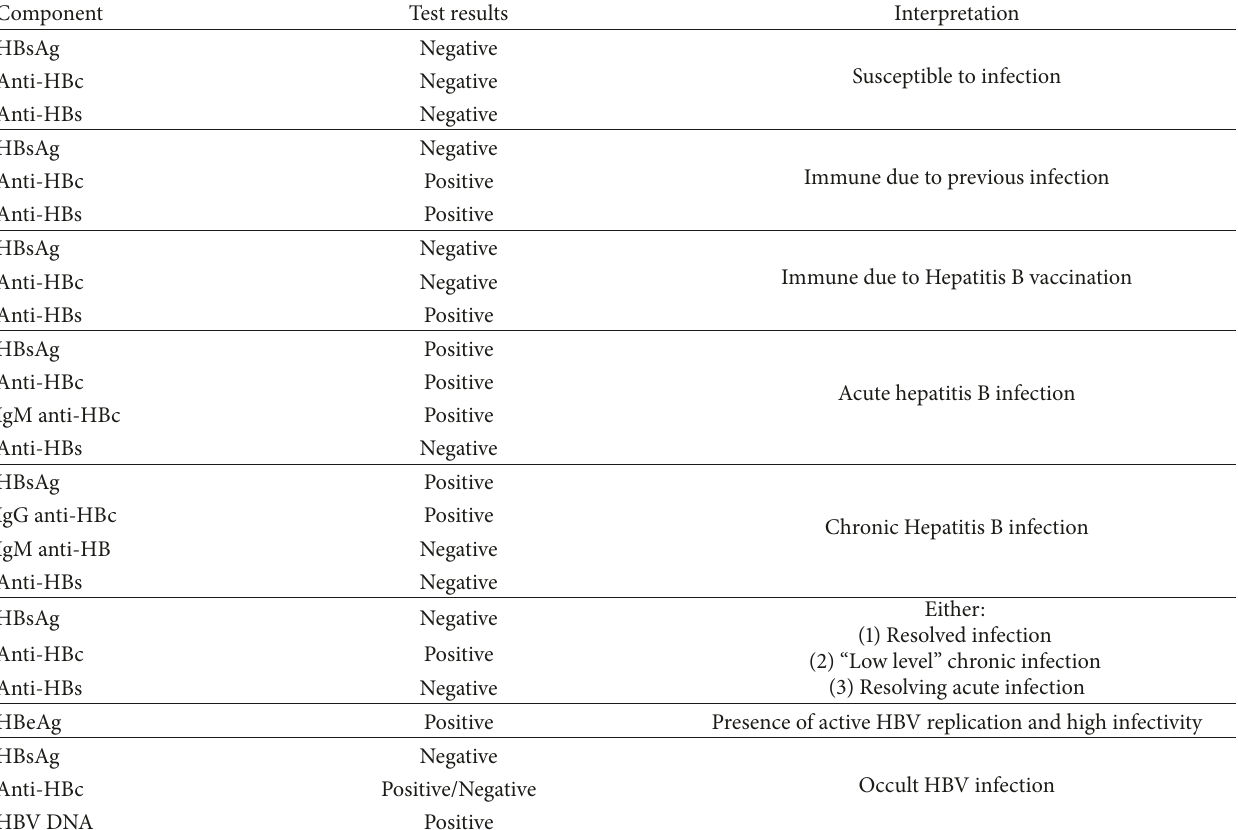
Table 1: Interpretation of Hepatitis B results